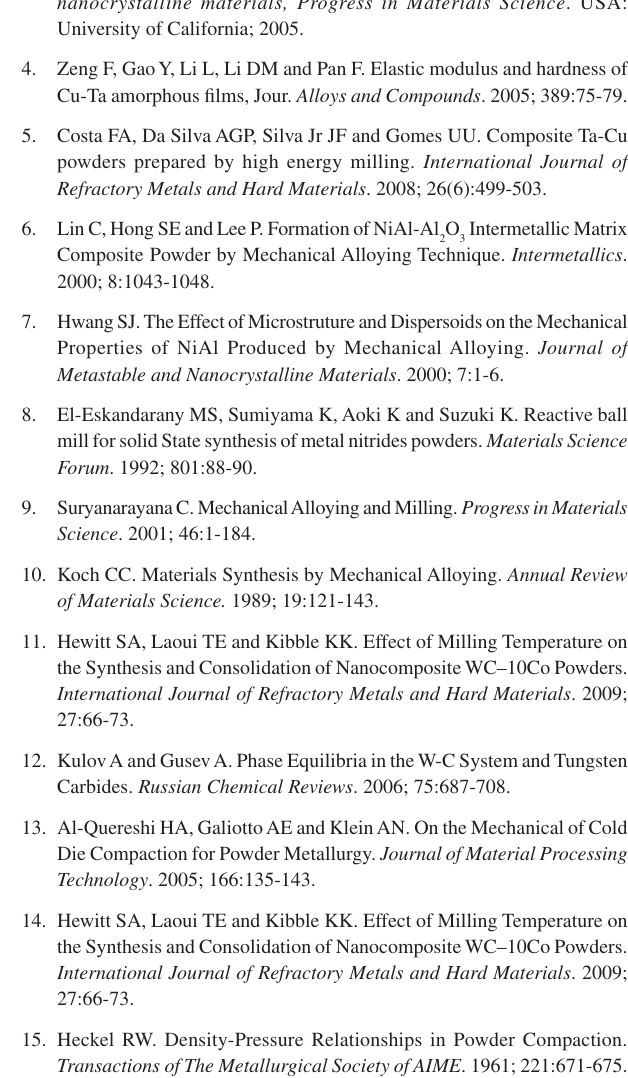
Table 2. Density after sintering. Milling time